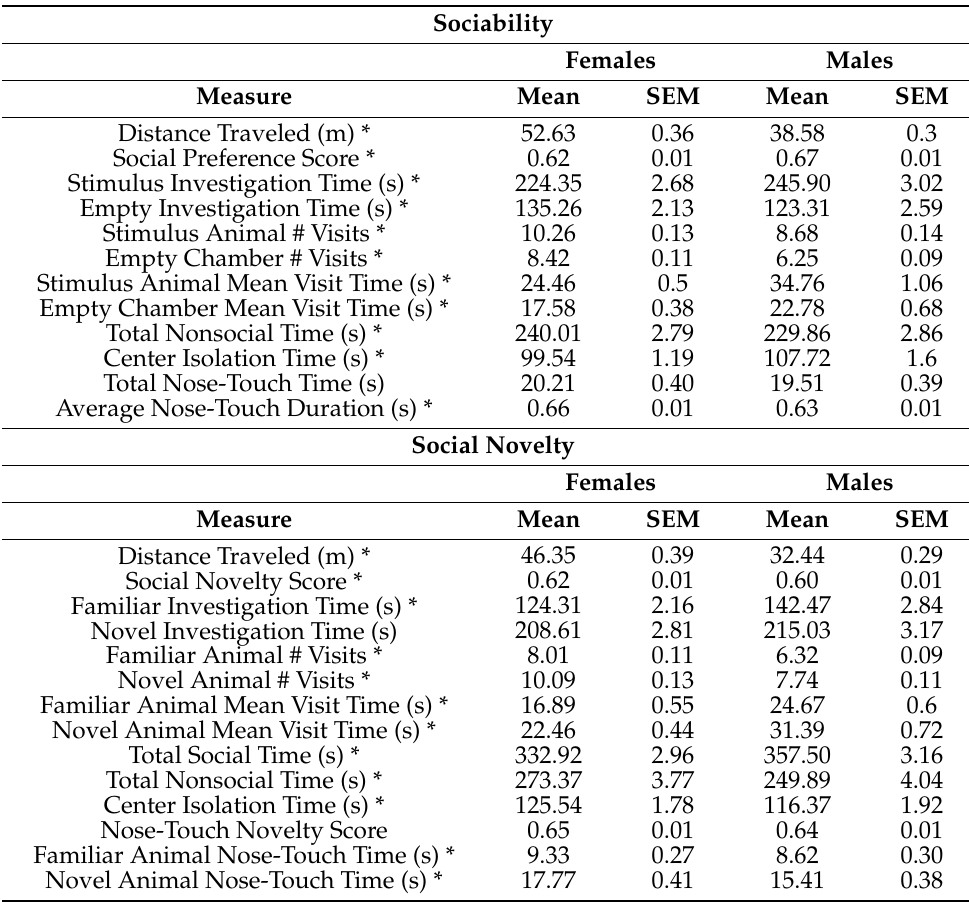
Table 2. Sex differences in the sociability and social novelty